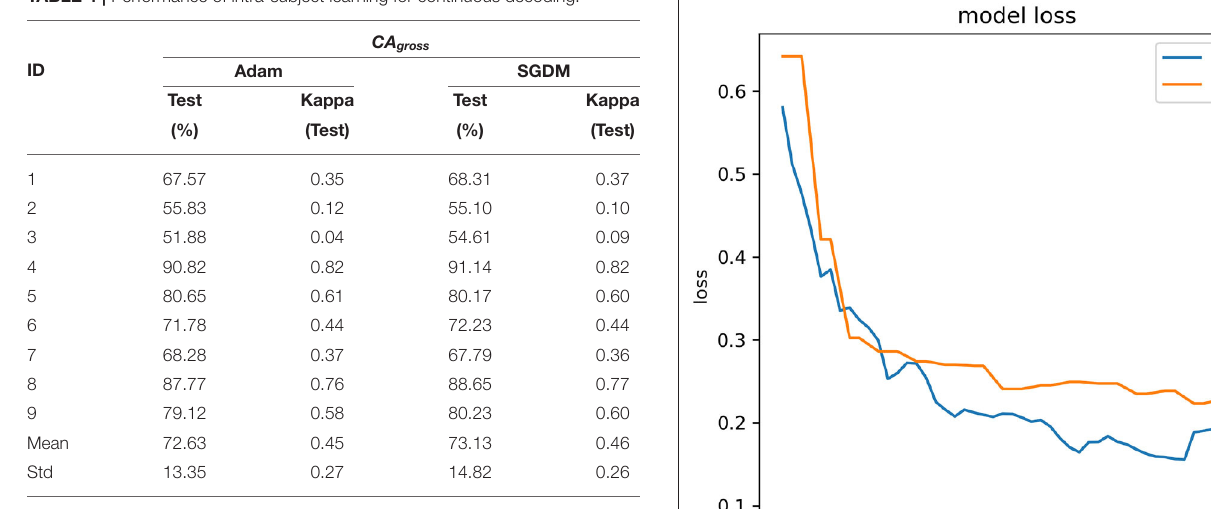
TABLE 4 | Performance of intra-subject learning for continuous decoding.